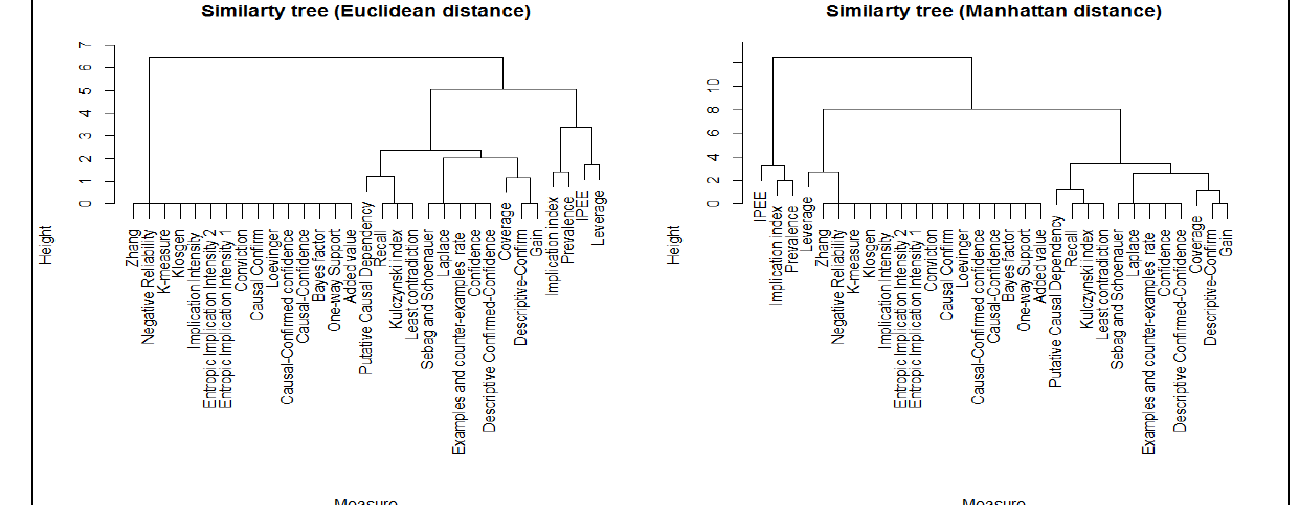
Figure 3: Similarity trees based on the statistical implication